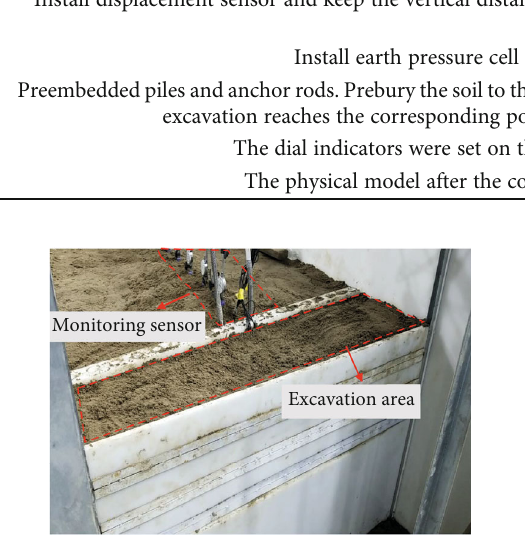
Figure 7: The physical model after the completion of embedded